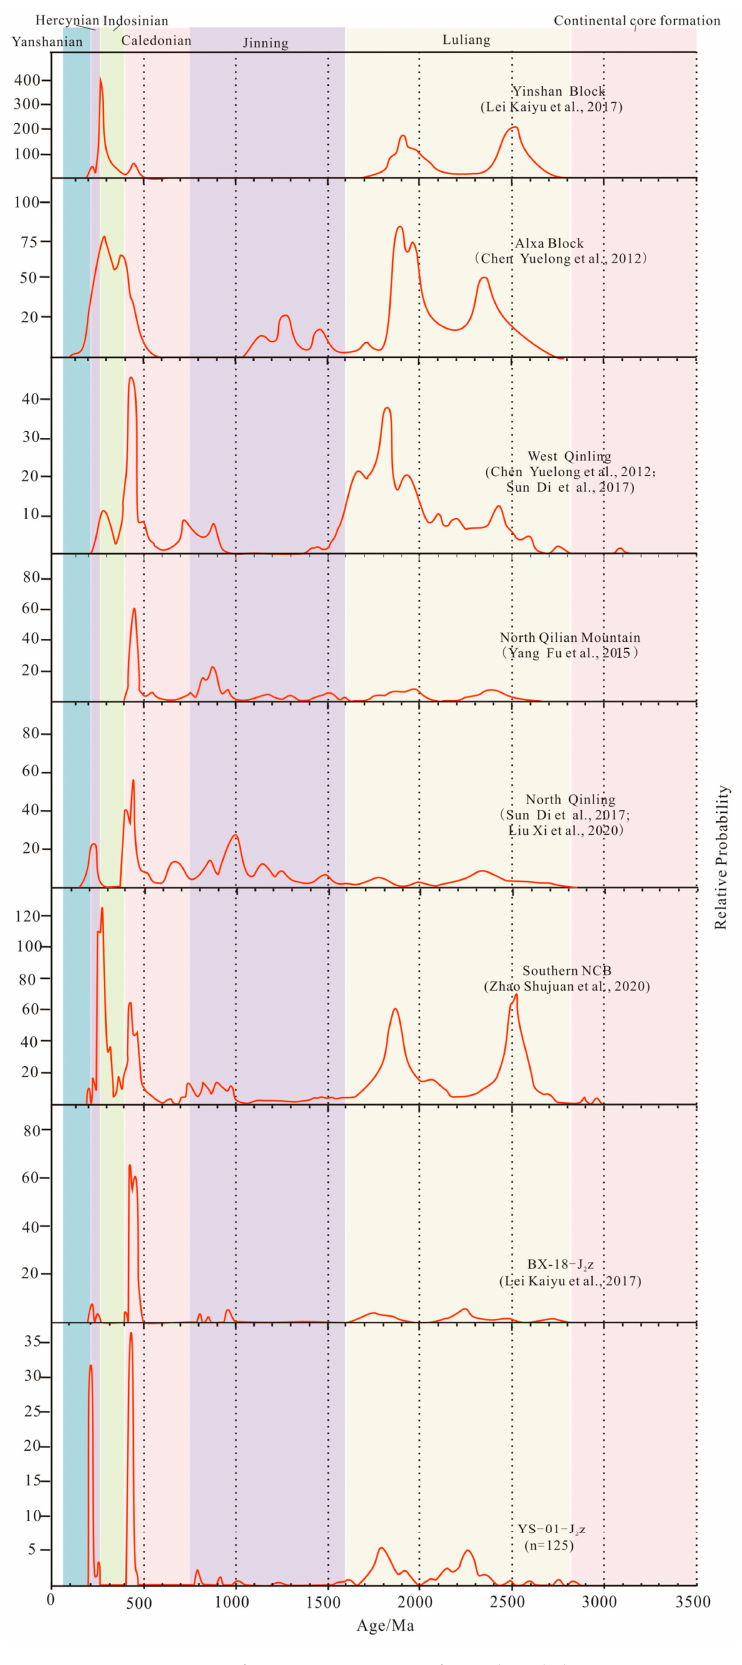
Figure 8. Comparison of zircon age spectra from the Zhiluo Formation in the southern Ordos basin and its adjacent areas (modified after